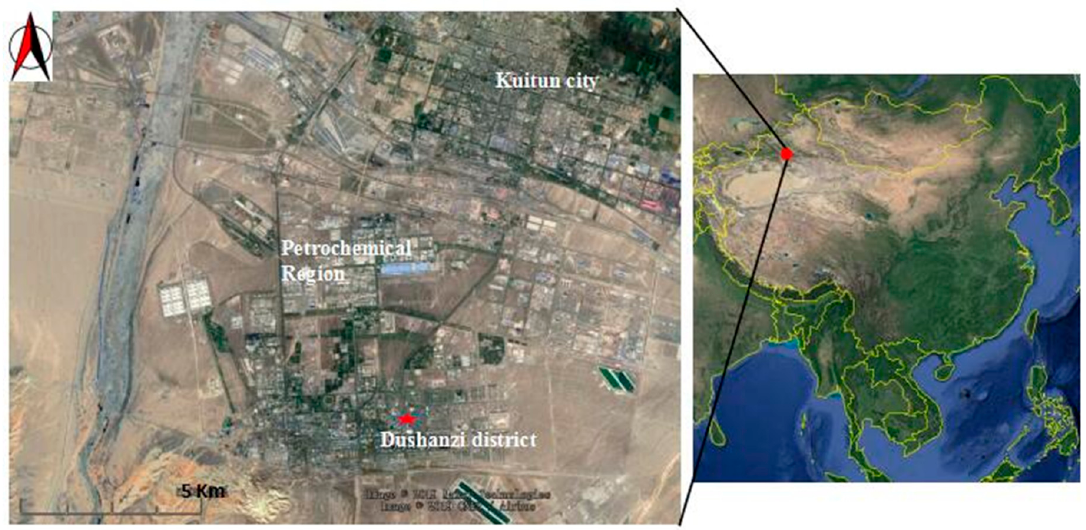
Figure 1. Location of the sampling site and residential area in the Dushanzi district.